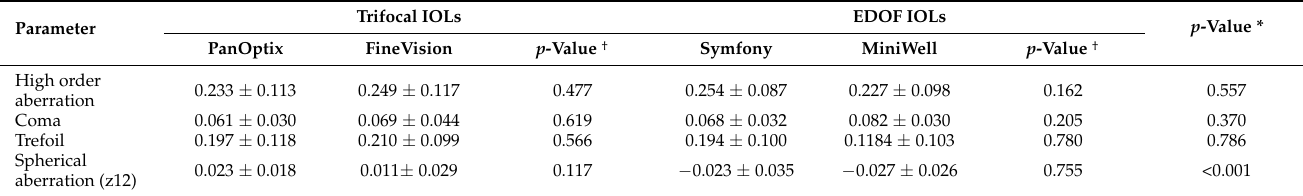
Table 3. Ocular higher-order aberrations in the four IOL groups (pupil size = 4.0